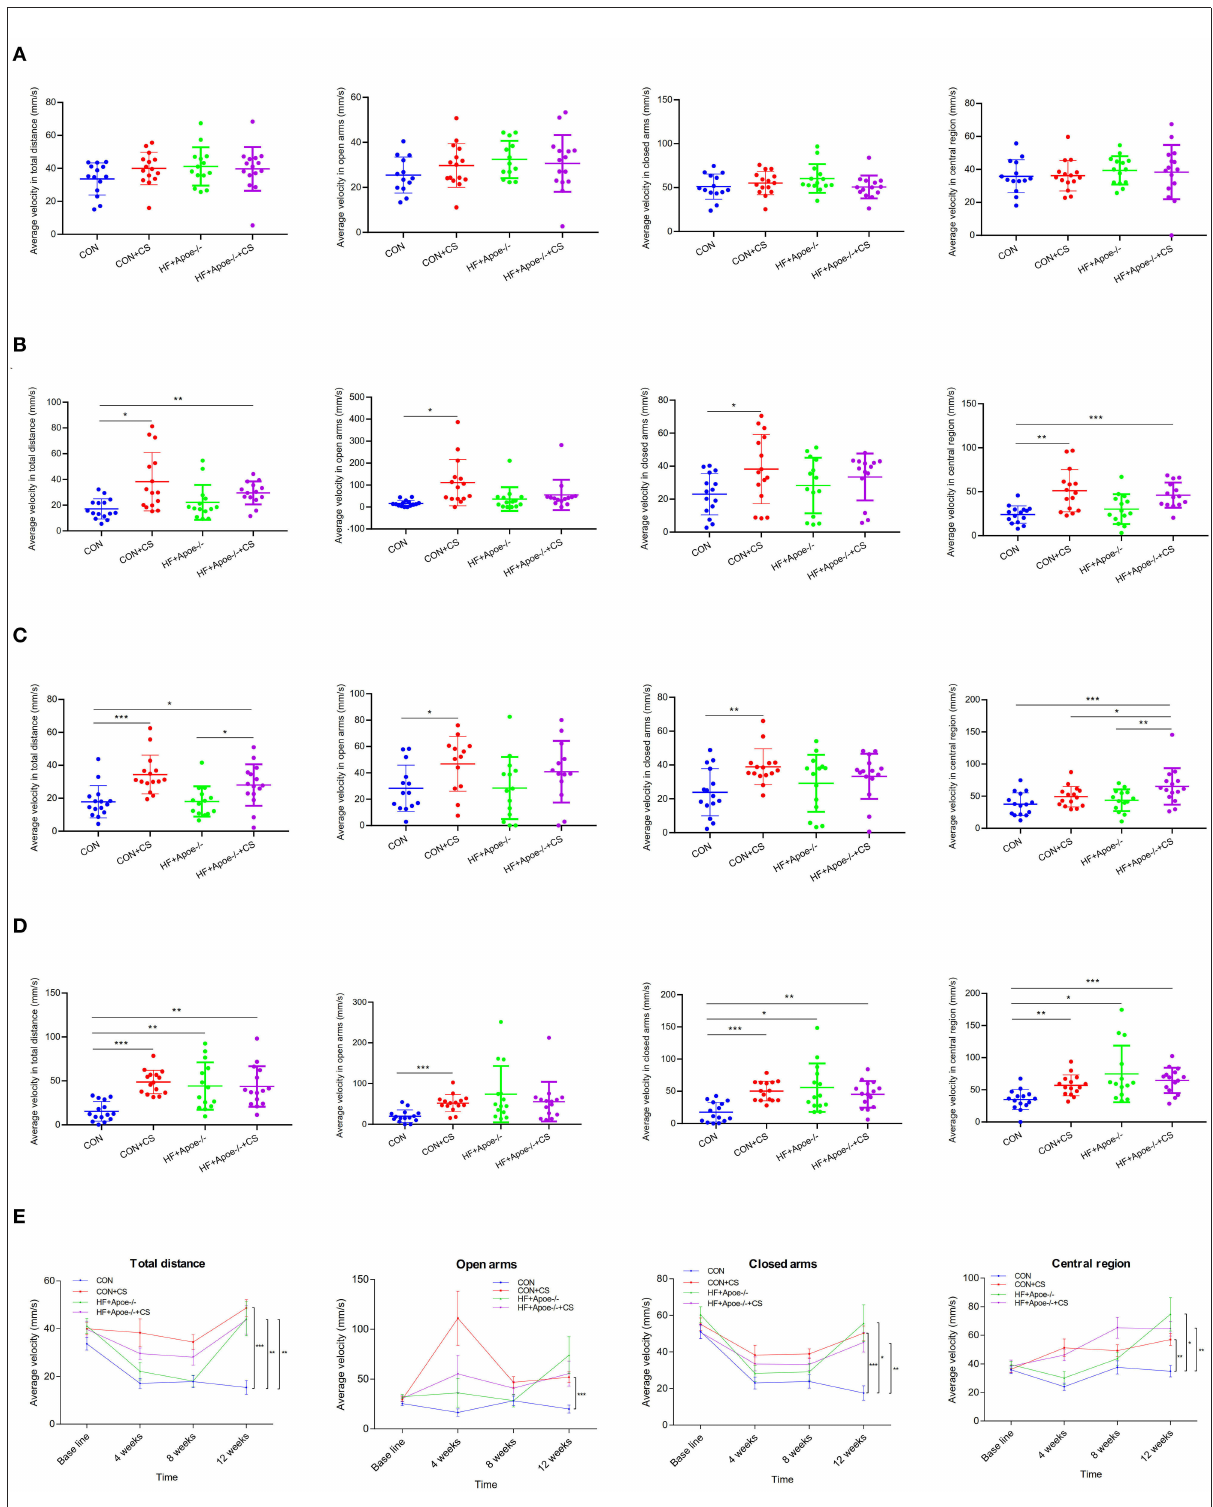
FIGURE1 Extremely excited state in the chronic stress model based on the elevated plus maze. (A) Baseline. (B) Four weeks. (C) Eight weeks. (D) Twelve weeks. (E) Trend of excitation over time is shown in the line chart. * P < 0.05; ** P < 0.01; *** P <